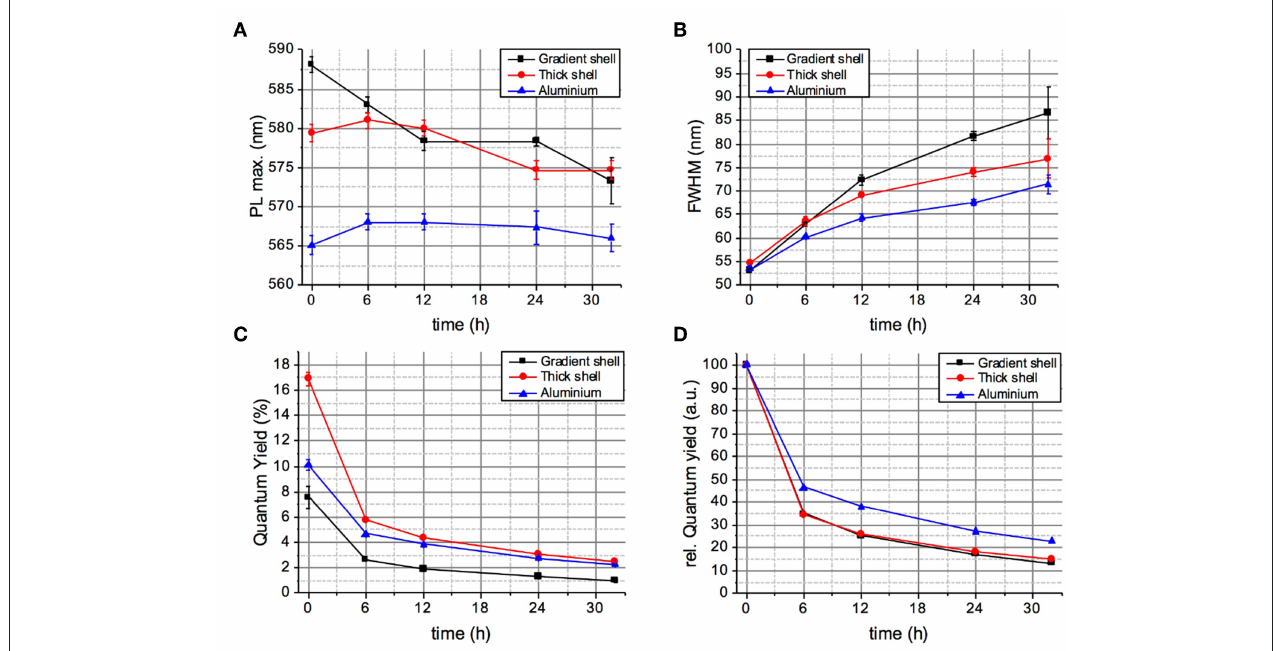
FIGURE 4 | Evolution of the PL maximum wavelength (A) , linewidth (B) , absolute PLQY (C) , and relative PLQY (D) of the QD-PMMA composites during 32h of continuous aging (irradiation with a solar simulator at 40 ◦ C).